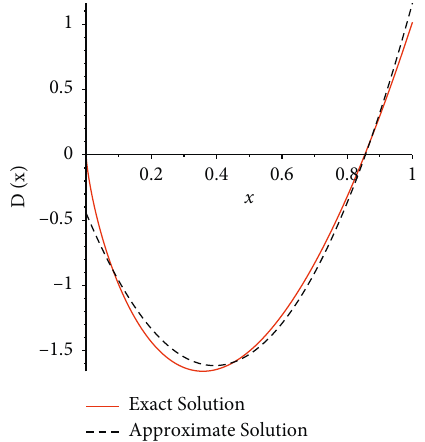
Figure 2: Comparison of the exact solution and approximation for ( x ) L 2